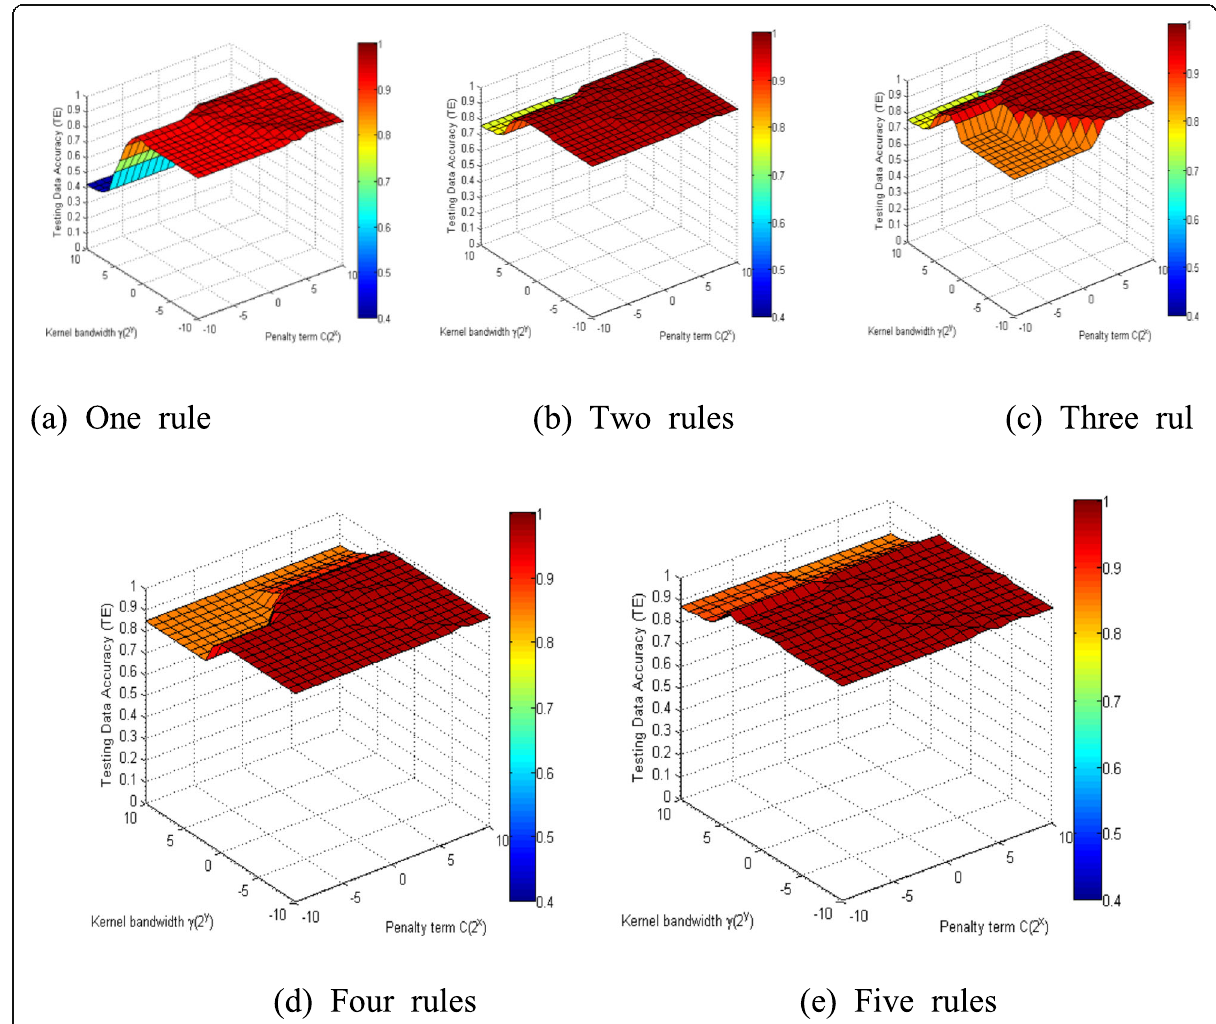
Fig. 5. Performance index (TE) range from one rule to five rules for the Iris